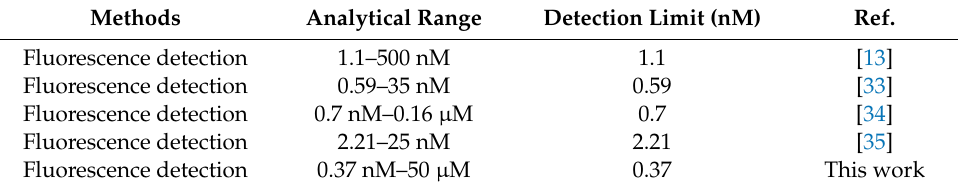
Figure 3. ( A ) Fluorescence emission spectra of the sensing method to different concentrations of thrombin. From a to i, the concentration of thrombin is 0, 0.05, 0.1, 0.2, 0.5, 1, 5, 10, 50 µM, respectively; ( B ) The linear region from 0.05 µM to 50 µM of thrombin, yielding a detection limit of 0.37 nM. The error bar was calculated in three independent experiments. Table 2. Comparison of the methods with a recently published investigation for thrombin.